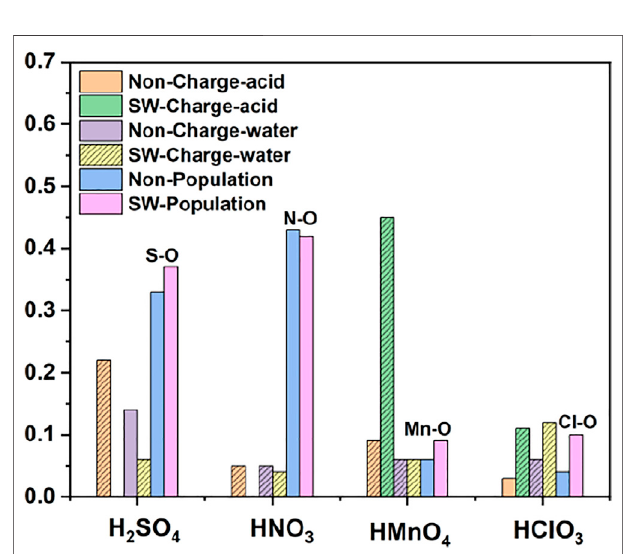
FIGURE 6 | Charge and bond population of single-component acid molecules reacting with the non-defect and Stone-Wales defect graphene in aqueous condition. The shadow indicates that this value is negative.